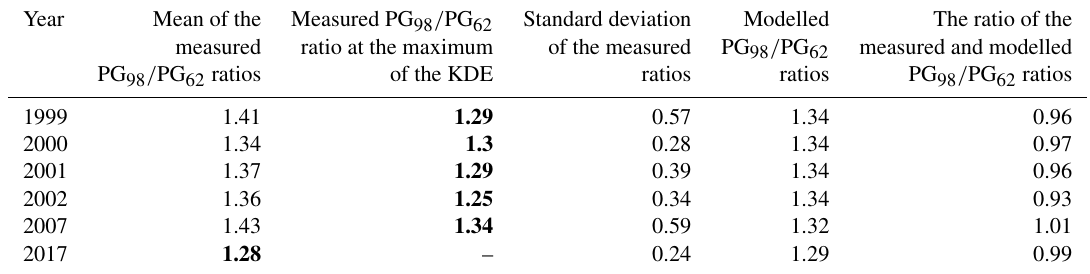
Table 2. Measured and modelled PG 98 / PG 62 ratios. Maximum of the KDE denotes the location of the maximum of the Gaussian kernel density estimation (KDE) function. Where both the mean and the KDE-based estimation of the PG 98 / PG 62 ratio were available, the one at the maximum of the KDE values was used to compare the measured ratios with the modelled ones. Measured ratios printed in bold were used in the